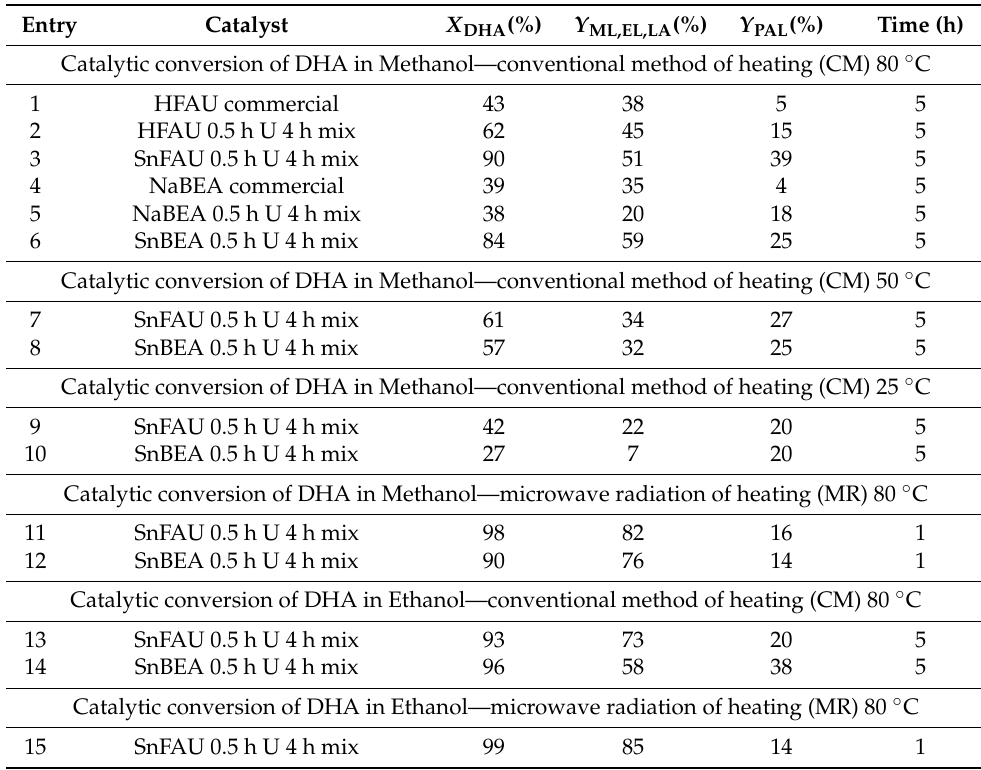
Table 3. Catalyticconversionofdihydroxyacetone(DHA)inmethanol, ethanolandwaterusingsynthesized hierarchical zeolites. The values were calculated in the following manner: Yields ( Y ML,EL,LA,PAL ) = mol of product j /mol of DHA at t = 0), Conversion DHA ( X DHA ) = Y ML,EL,LA,PAL /selectivity to product j , where j = ML or EL, LA or pyruvic aldehyde (PAL) [27]. Please note that entries 18–20 are catalyst after subsequent recyclings (abbreviation: